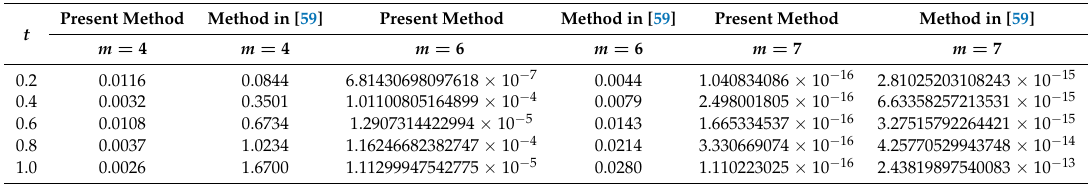
Table 1. The comparison absolute errors of the present scheme and method given in [59] with m =